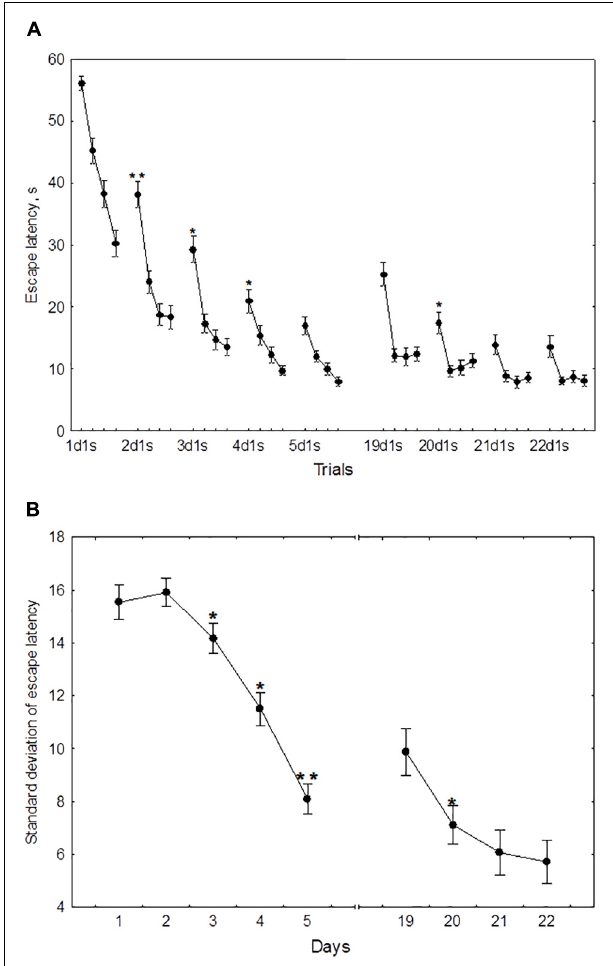
FIGURE 2 | Mean (A) and standard deviation (B) of the escape latency for the initial learning (days 1–5) and the repeated learning (days 19–22). * p < 0.05 and ** p < 0.01 relative to the previous day.